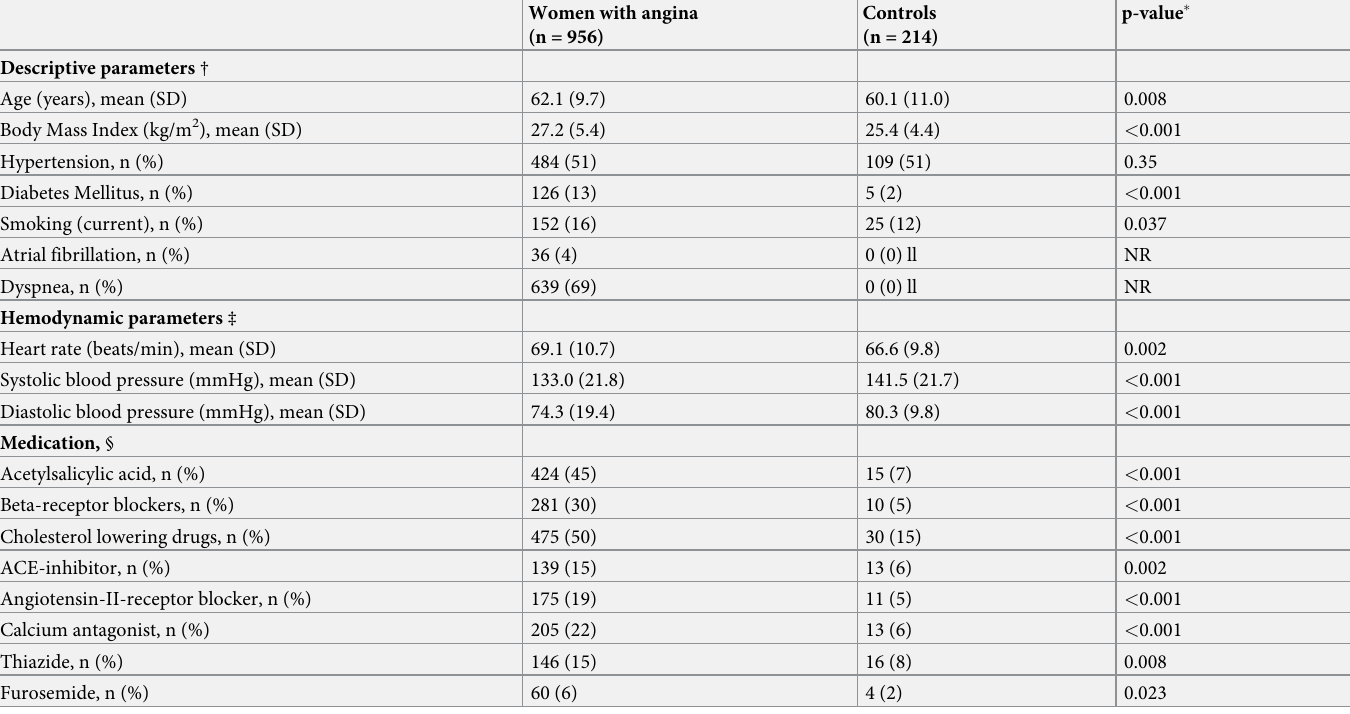
Table 1. Background characteristics of women with angina and no obstructive coronary artery disease and